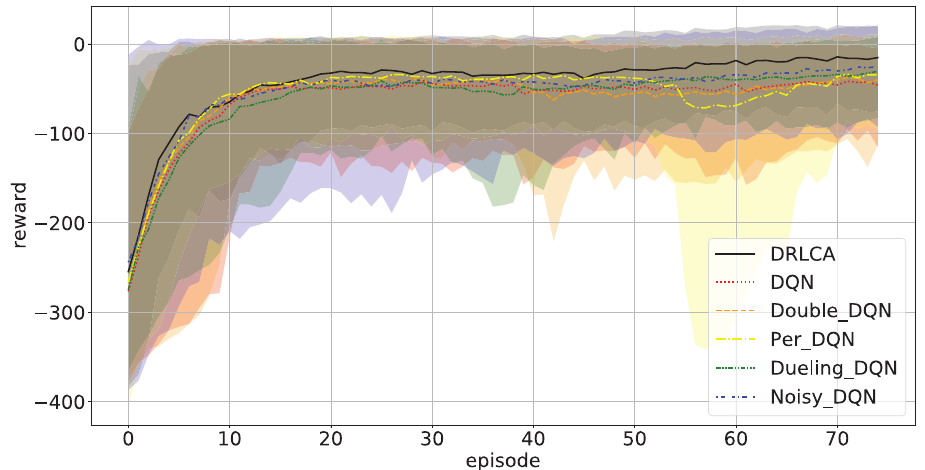
Figure 8. Average